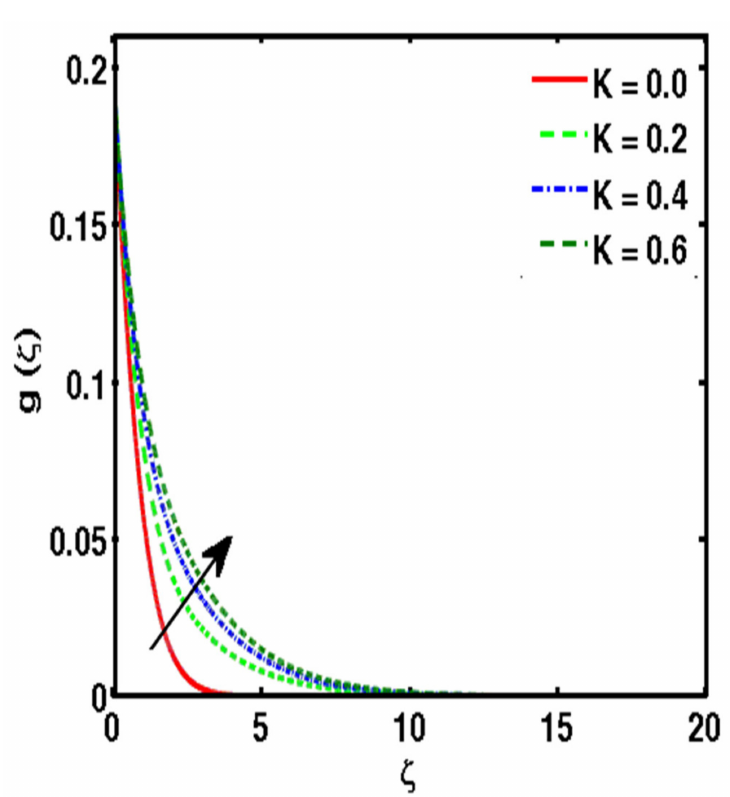
Figure 10. Variation of K and F (cid:48) ( ζ )